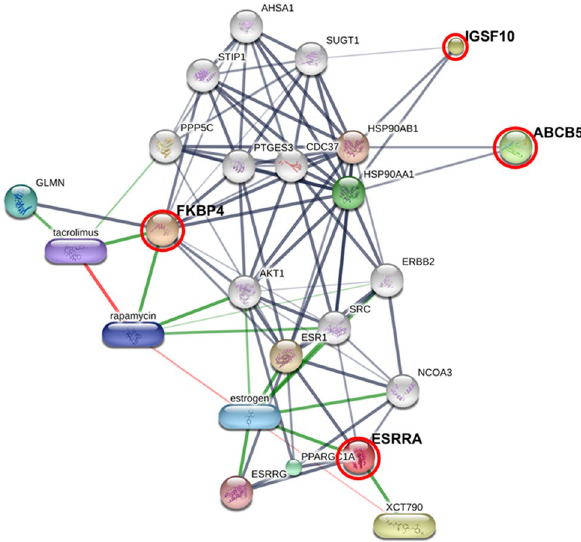
Figure 5. Involvement of peptidyl-prolyl cis-trans isomerase FKBP4 isoform X2 (FKBP4), steroid hormone receptor ERR1 (ESRRA), immunoglobulin superfamily member 10 (IGSF10) and ATP-binding cassette subfamily B member 5 (ABCB5) in networks of protein–chemical agent interactions based on KEGG pathways. Red circles: FKBP4, ESRRA, IGSF10 and ABCB5. Abbreviations: AHSA1, activator of heat shock 90 kDa protein ATPase homolog 1 (also known as AHA1); AKT1, v-akt murine thymoma viral oncogene homolog 1; CDC37, cell division cycle 37 homolog; ERBB2, v-erb-b2 erythroblastic leukemia viral oncogene homolog 2 (neuro/ glioblastoma derived oncogene homolog); ESR1, estrogen receptor 1 (nuclear hormone receptor); ESRRG, estrogen-related receptor gamma; GLMN, glomulin (FKBP associated protein); HSP90AA1, heat shock protein 90 kDa alpha (cytosolic), class A member 1; HSP90AB1, heat shock protein 90 kDa alpha (cytosolic), class B member 1; NCOA3, nuclear receptor coactivator 3; PPARGC1A, peroxisome proliferator-activated receptor gamma, coactivator 1 alpha; PPP5C, protein phosphatase 5, catalytic subunit; PTGES3, prostaglandin E synthase 3 (cytosolic); SRC, v-src sarcoma (Schmidt-Ruppin A-2) viral oncogene homolog; STIP1, stress-induced- phosphoprotein 1; SUGT1, suppressor of G2 allele of SKP1 (also known as SGT1). Chemical agents: estrogen, rapamycin, tacrolimus and